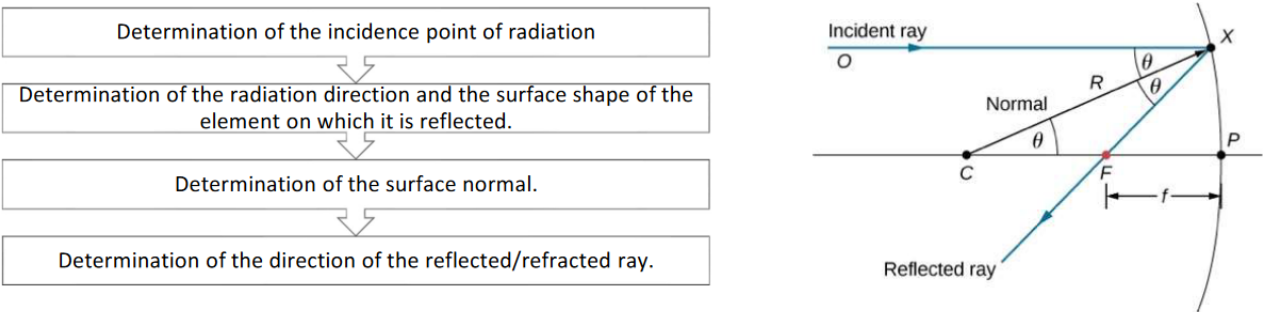
Figure 5. Tracing of direction of rays reflected by a reflective surface.